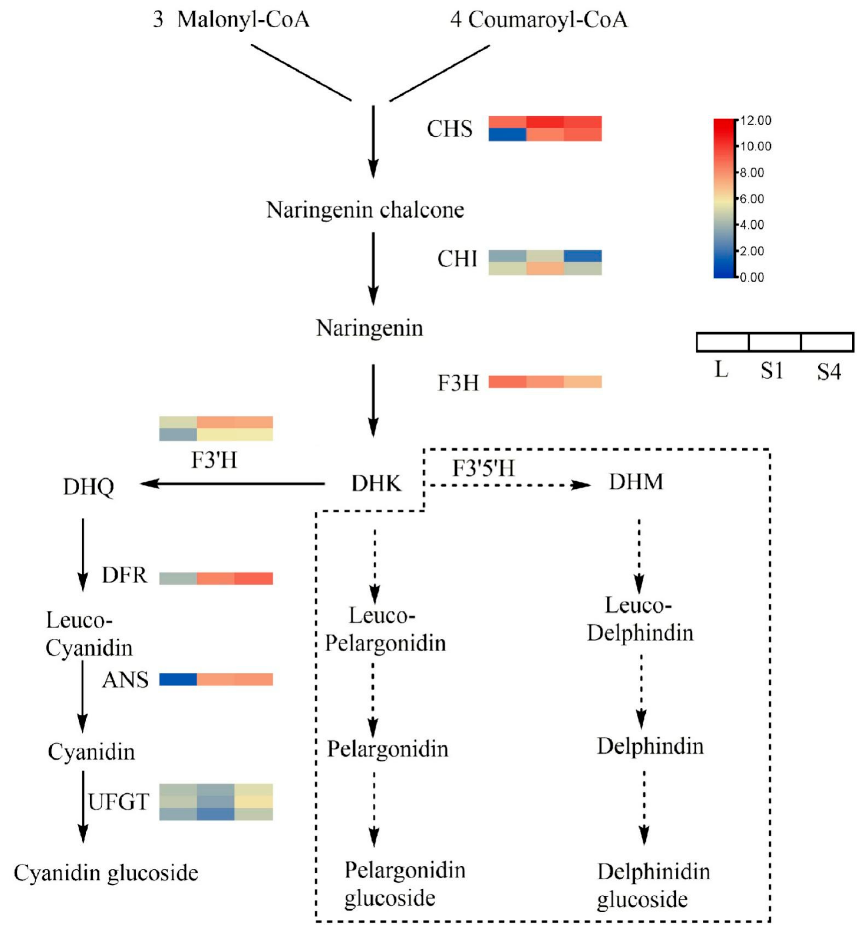
Figure 5. The biosynthesis of anthocyanin and gene expression. The color shows the normalized expression score from log 2 (FPKM+1) of DEGs. Solid lines, pathways present; dotted box and dotted arrows, pathways absent. Abbreviations: chalcone synthase, CHS; chalcone isomerase, CHI; flavanone 3-hydroxylase, F3H; flavonoid 3'-hydroxylase, F3'H; dihydroflavonol 4-reductase, DFR; anthocyanidin synthase, ANS; dihydrokaempferol, DHK; dihydroquercetin, DHQ; dihydromyricetin, DHM; UDP-glucosyl transferase, UFGT.